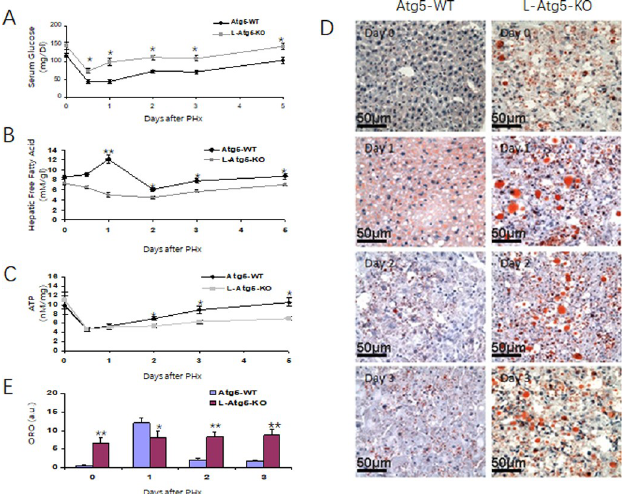
Fig 6. The metabolic responses to PHx in Atg5-WT and L-Atg5-KO mice. Serum glucose levels (A), Hepatic free fatty acid levels (B) and Hepatic ATP levels (C) were measured at serial times after PHx. (D) Neutral lipid accumulation in liver tissues from PHx mice was analyzed by oil red O staining. (E) Quantification of neutral lipids at indicated time points. The results represented the mean of 20 different viewing fields statistically significant. In (A), (B) and (C), 5 mice were analyzed for every time point and the results represented the mean ± s.e.m. of at least three mice. � , p < 0.05; �� , p < 0.01.